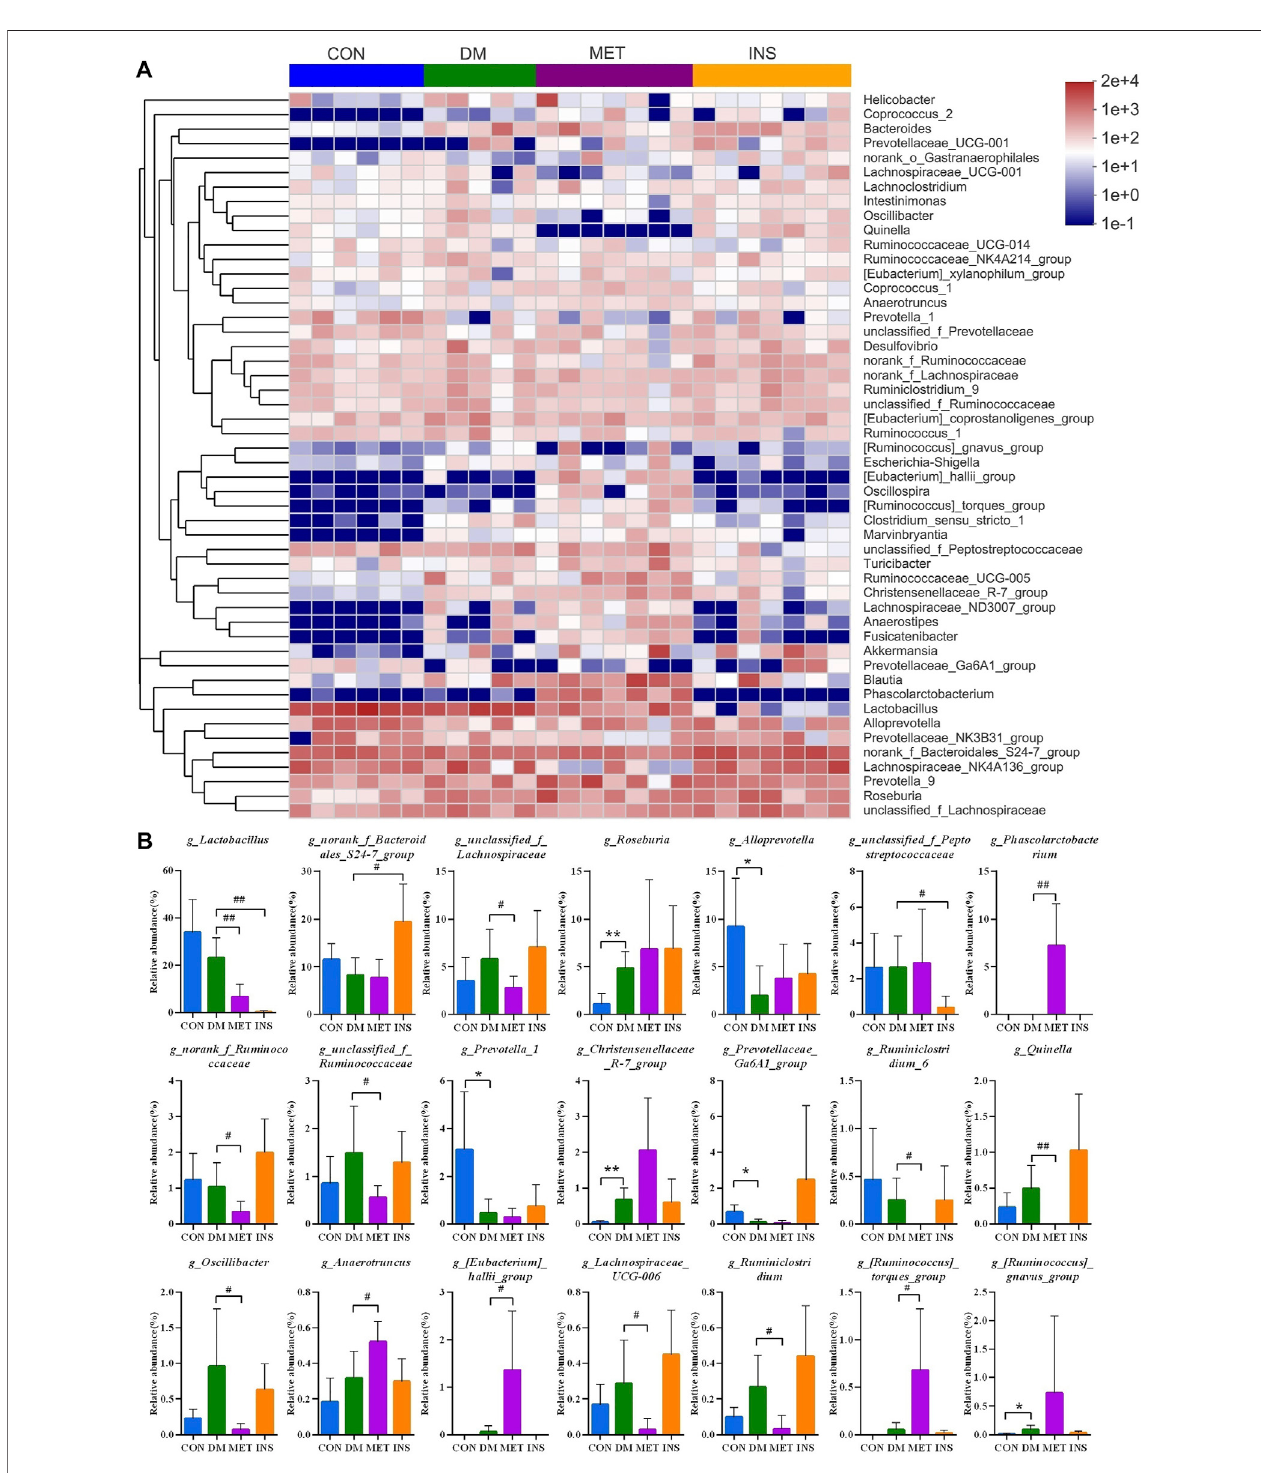
FIGURE3 | The detailed effects of metformin on the gut microbiota ofdiabeticrats at the genus level. (A) therelativeabundances of 50dominantgenera in the gut microbiota of four groups are presented in a heatmap. (B) Relative abundances of g_Lactobacillus , g_norank_f_Bacteroidales_S24-7_group , g_unclassi fi ed_f_Lachnospiraceae , g_Roseburia , g_Alloprevotella , g_unclassi fi ed_f_Peptostreptococcaceae , g_Phascolarctobacterium , g_Ruminiclostridium_9 , g_norank_f_Ruminococcaceae , g_Desulfovibrio , g_Turicibacter , g_unclassi fi ed_f_Ruminococcaceae , g_Prevotella_1 , g_Christensenellaceae_R-7_group , g_Prevotellaceae_Ga6A1_group , g_Ruminiclostridium_6 , g_Quinella , g_Prevotellaceae_UCG-001 , g_Oscillibacter , g_Clostridium_sensu_stricto_1 , g_Anaerotruncus , g_(Eubacterium)_hallii_group , g_Lachnospiraceae_UCG-006 , g_Ruminiclostridium , g_(Ruminococcus)_torques_group and g_(Ruminococcu)_gnavus_group inthegut microbiota of four groups. * p < 0.05, ** p < 0.01 vs. CON group. # p < 0.05, ## p < 0.01 vs. DM group.